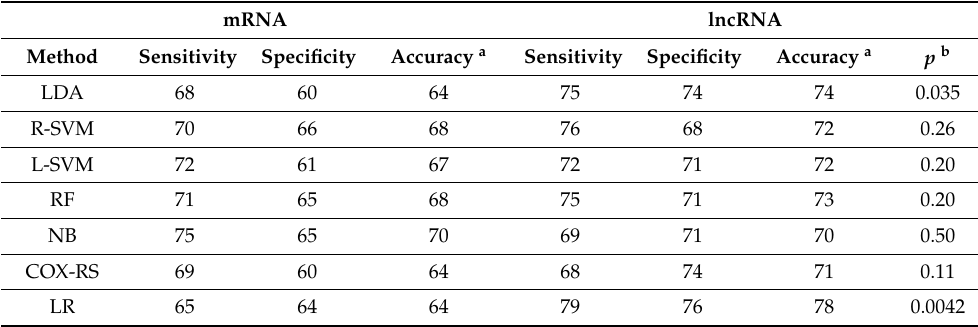
Table 4. Classification with optimized balanced accuracy using seven individual machine learn- ing methods.